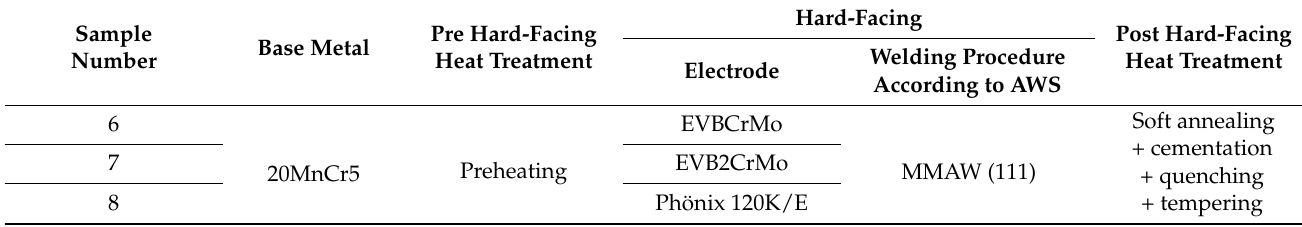
Table 3. Preparation technology of samples hard-faced by the “soft” filler metal.